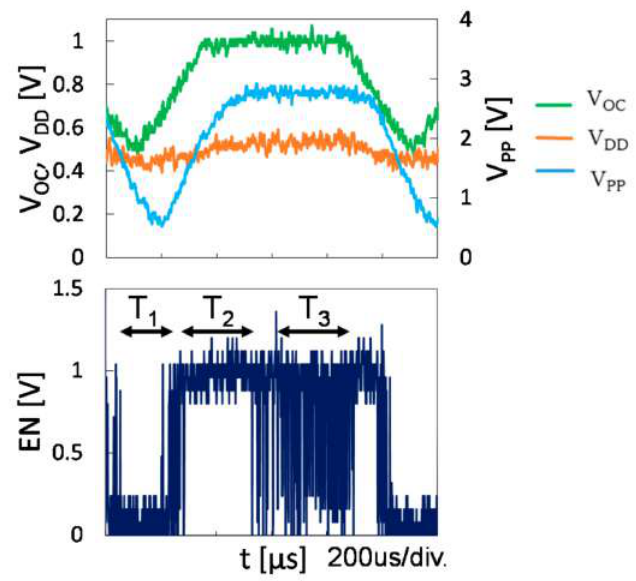
Figure 9. Dynamic behavior of V PP and V DD against V OC